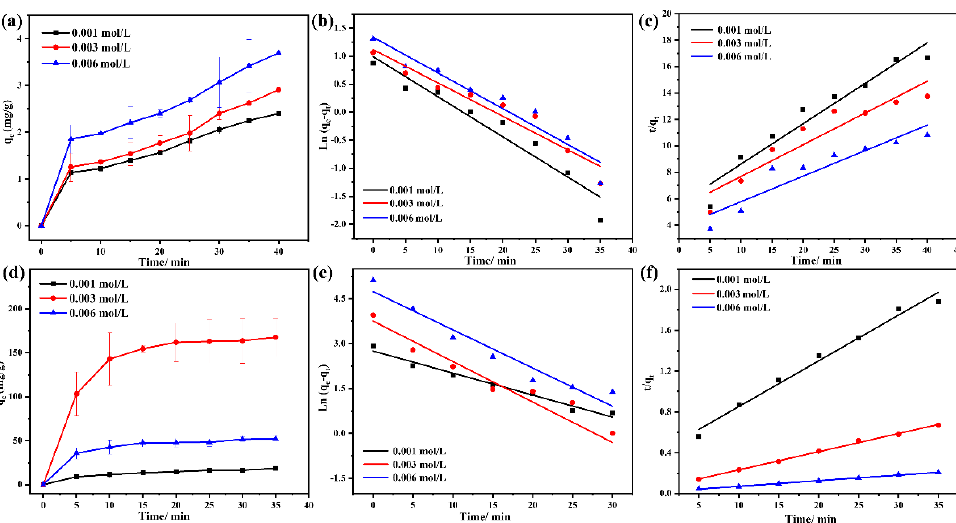
Figure 7. ( a ) The effect of the different initial In(III) concentration on the adsorption capacity; the linear fit with pseudo − first − order ( b ) and pseudo − second − order ( c ) models of In(III) adsorbed on EGCG. ( d ) The effect of the different initial Fe(III) concentrations on the adsorption capacity; the linear fit with pseudo − first − order ( e ) and pseudo − second − order ( f ) models of Fe(III) adsorbed on EGCG.